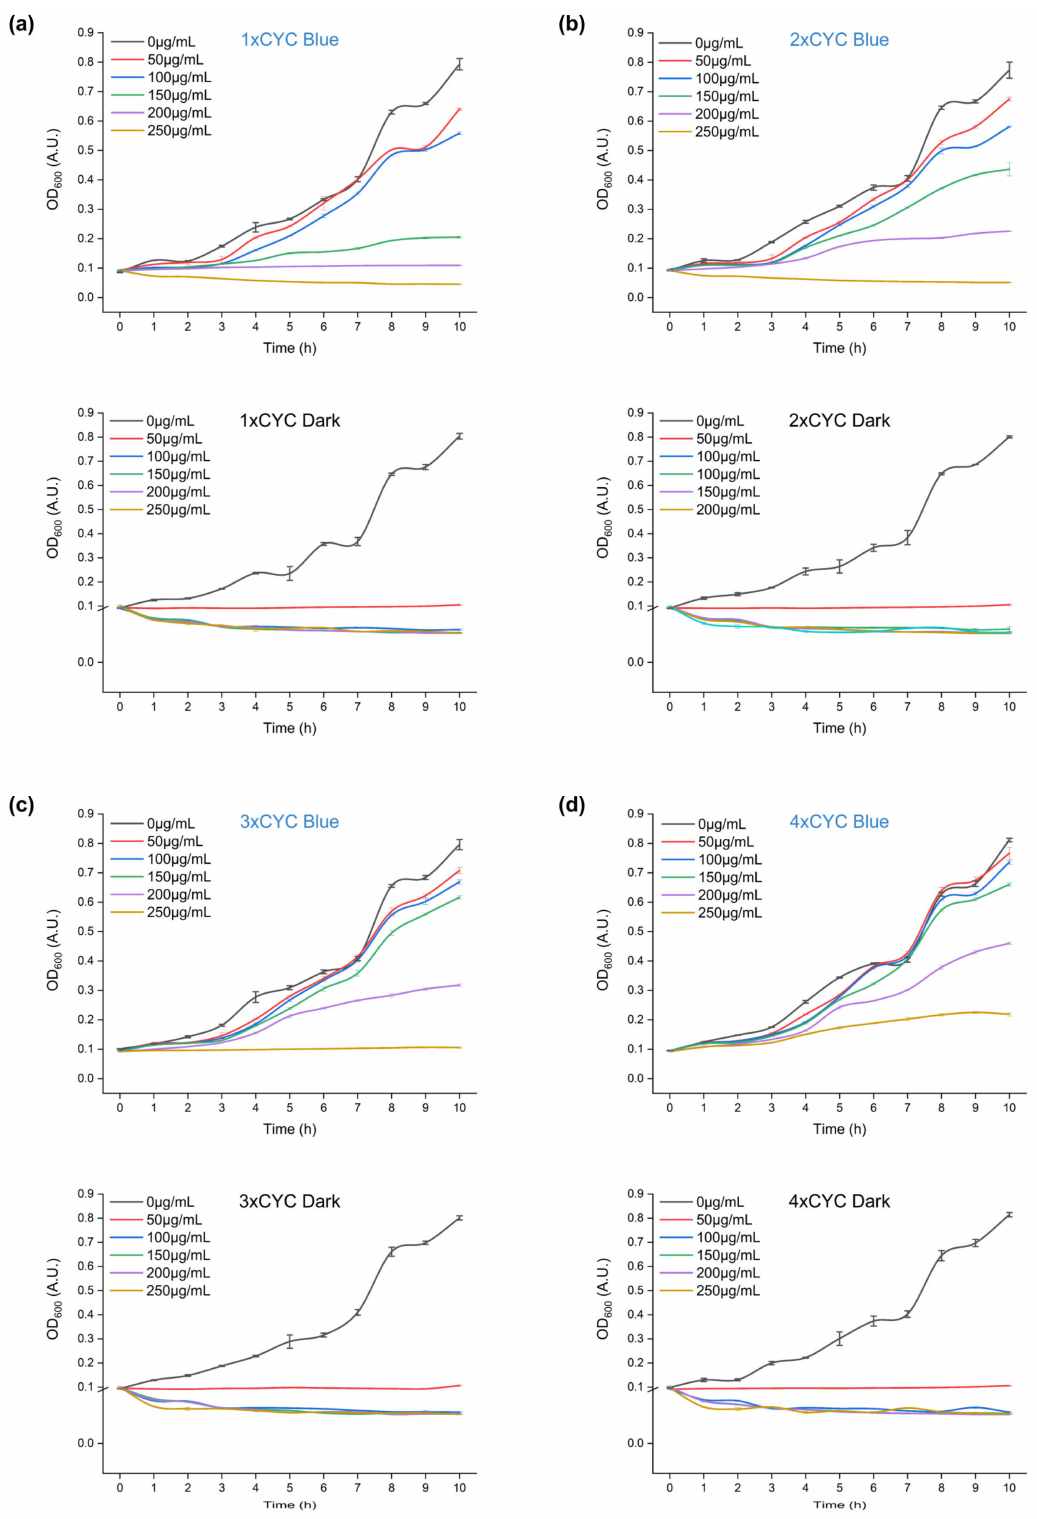
Figure 7. Blue light-induced antibiotic resistance. ( a – d ) show the growth profile of Po1g cells harboring 1~4 × CYC plasmids under bleomycin concentration gradient, respectively. In sub-panels, the blue title represents the blue light-induced experimental group, and the black title represents the dark-cultured control group. Hence, incubation in constant blue light induces BleoR expression and facilitates growth even in the presence of high concentrations of the antibiotic. Error bars indicate means ± S.D. (n =